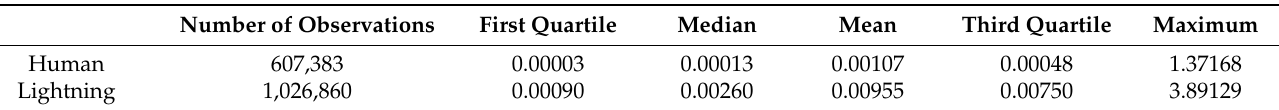
Table 4. Summary statistics of historical fire occurrence prediction model data (expected number of fires/cell) generated